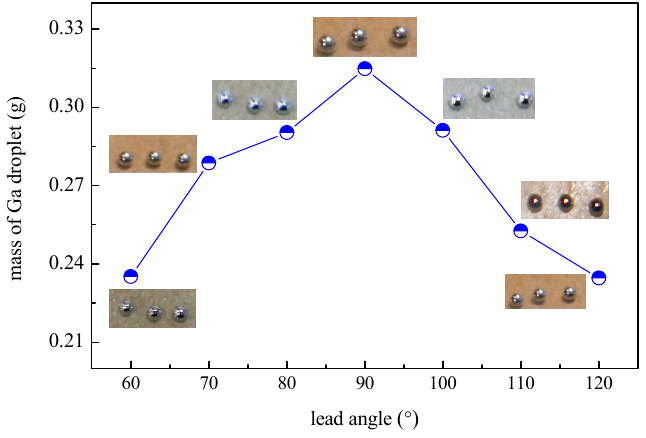
Figure 5. Mass of liquid Ga droplets as a function of the lead angle.